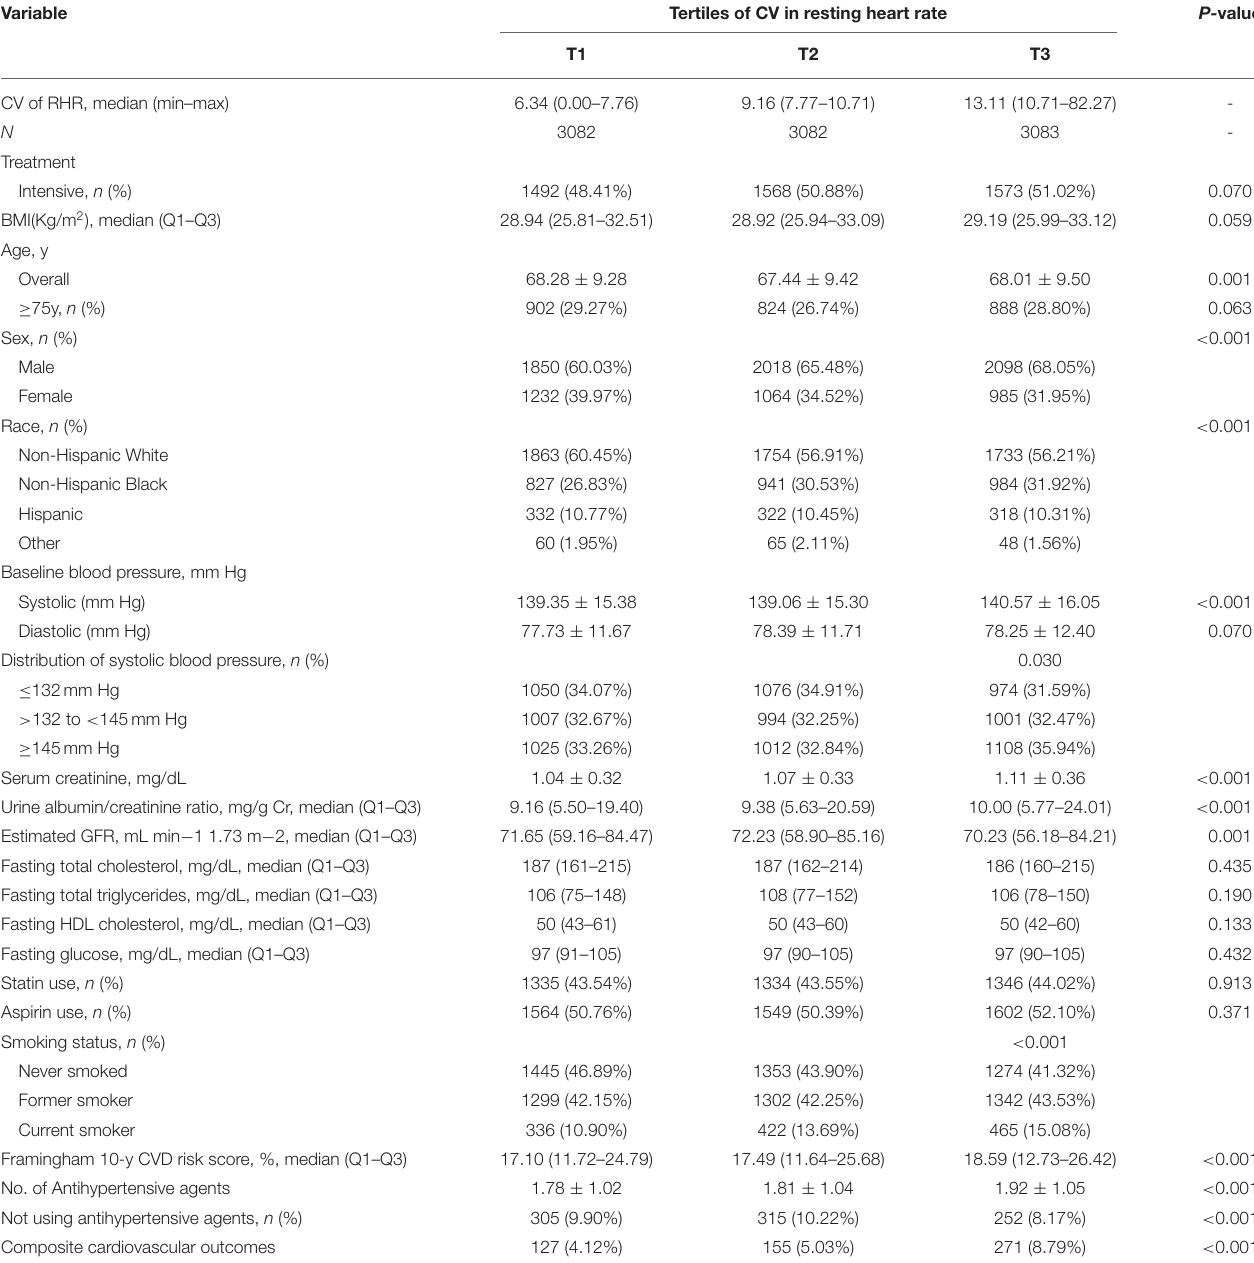
TABLE 1 | Baseline characteristics and crude outcomes of the participants according to coefficient of variation in resting heart rate.